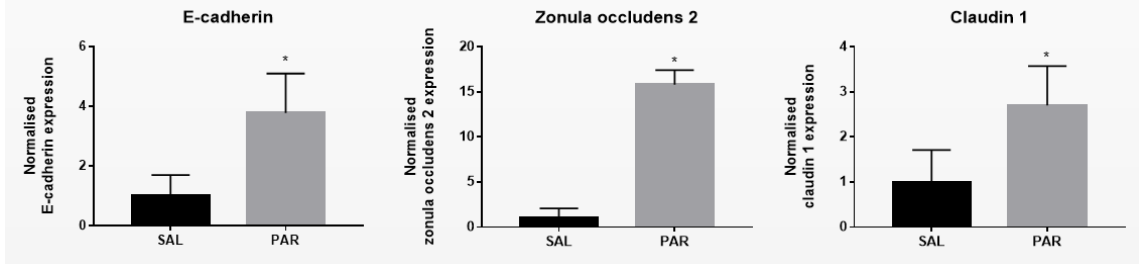
Figure 2: Effect of acute liver disease on mRNA levels of hepatic cell junction components. Mice were injected with SAL or PAR solution. After 24 hours, mRNA was extracted from the liver and sub- jected to RT-qPCR analysis of E-cadherin, β-catenin, γ-catenin, Cx26, Cx32, Cx43, zonula occludens 2 and claudin 1. Fold changes in RNA levels were calculated, where the average expression of SAL- treated animals was set to 1. Results were analyzed by 2-tailed unpaired student t-tests and Welch’s correction. Data were expressed as means ± SD (* p ≤ 0.05) ( n = 4-5; N = 2).